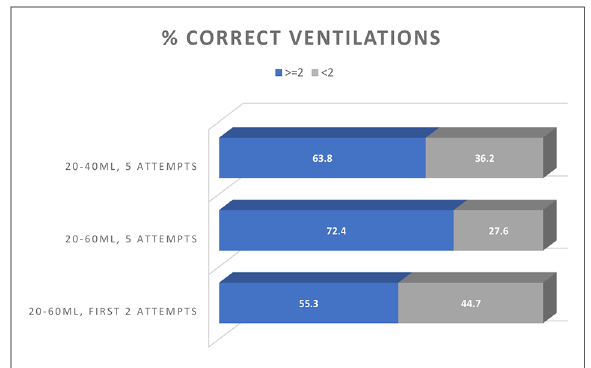
FIGURE 2 Correct ventilations as part of the IRB. Percentages of duos that performed at least two correct ventilations (considering either 20 – 4 ml and 20 – 60 ml target volumes) within the fi ve IRB and alternatively only considering the fi rst two of these fi